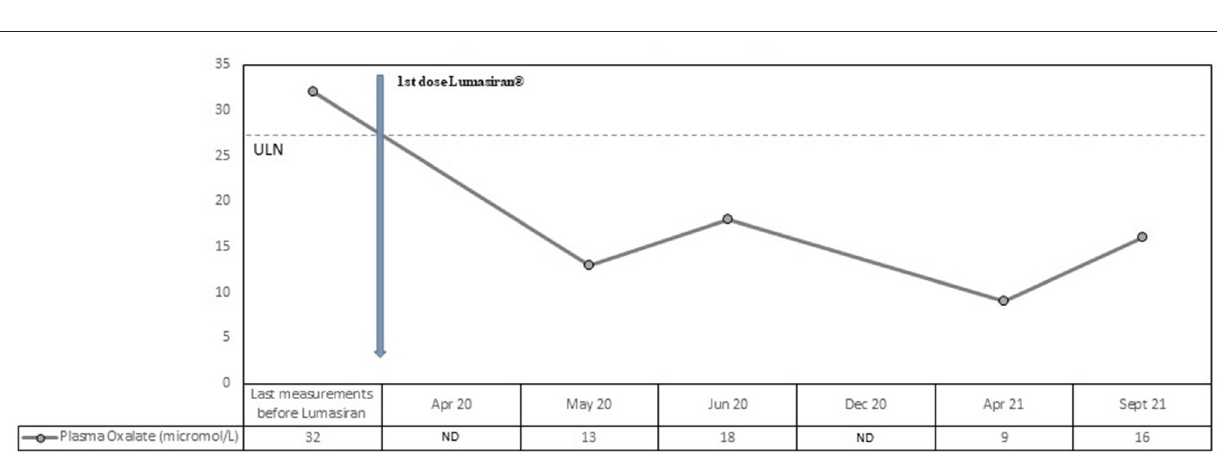
FIGURE 2 | Observed values for Plasma Oxalate from the last measurement before lumasiran to Month 18. ULN denotes upper limit of the normal